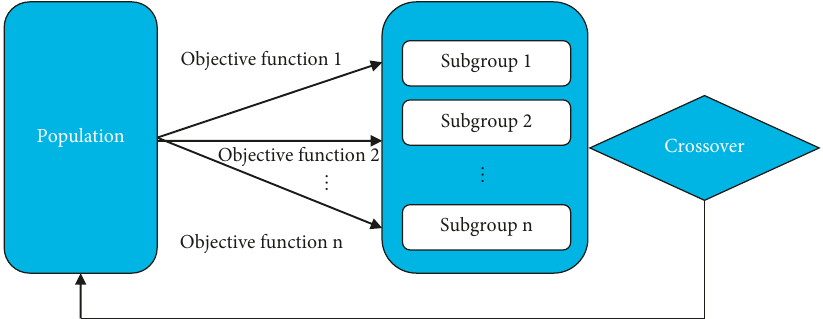
Figure 2: Schematic diagram of the parallel selection